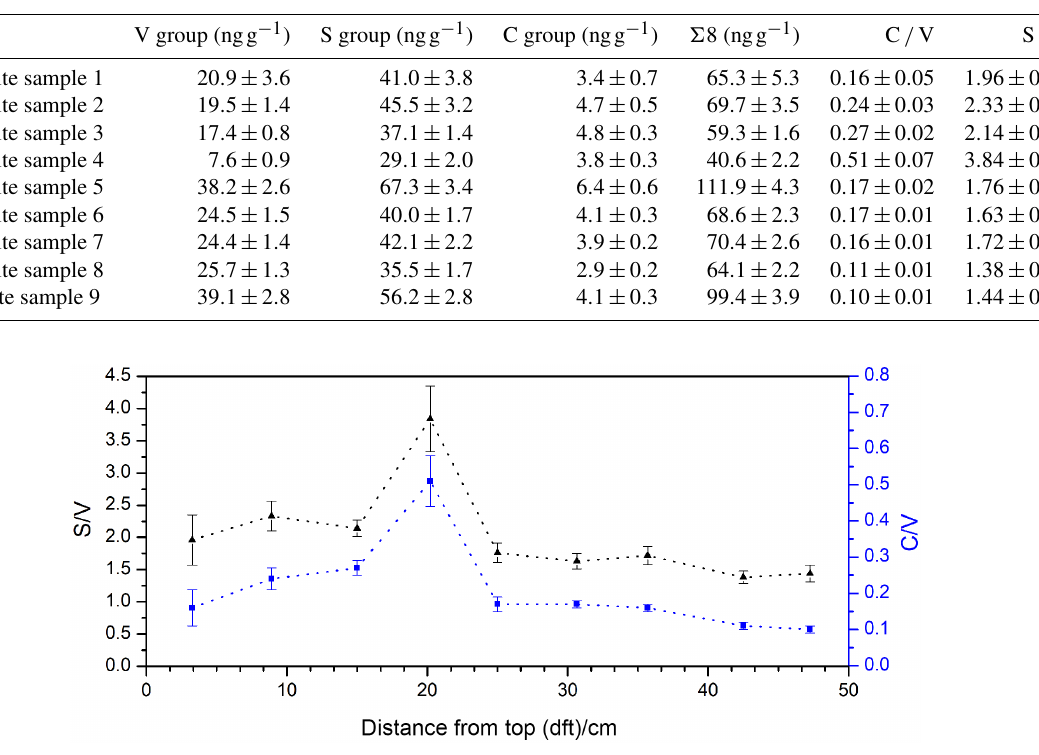
Figure 7. S / V (black triangles, left axis) and C / V (blue squares, right axis) ratios of stalagmite NG01 plotted against the distance from the top of the